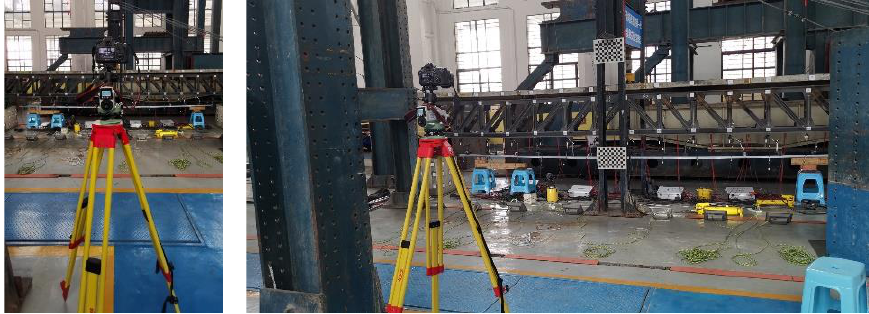
Figure 6. Position of measuring camera.